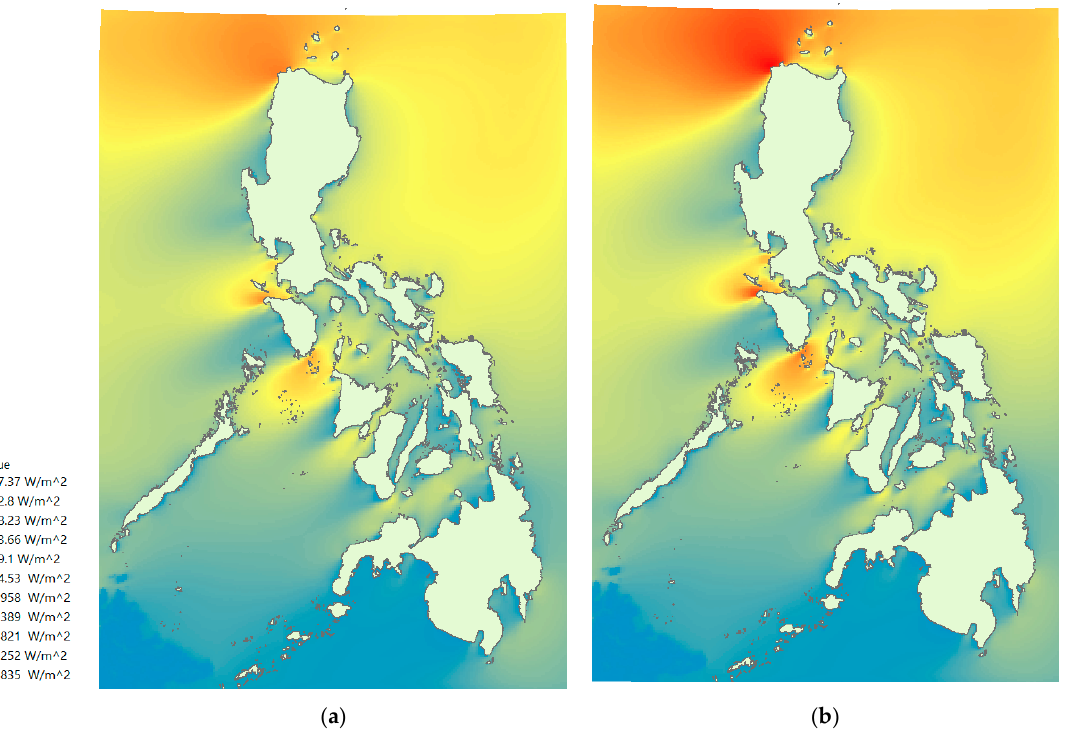
Figure 17. Wind power density for ( a ) SWT-3.6-120 and ( b ) 6.2M126. J. Mar. Sci. Eng. 2021 , 9 , x FOR PEER REVIEW